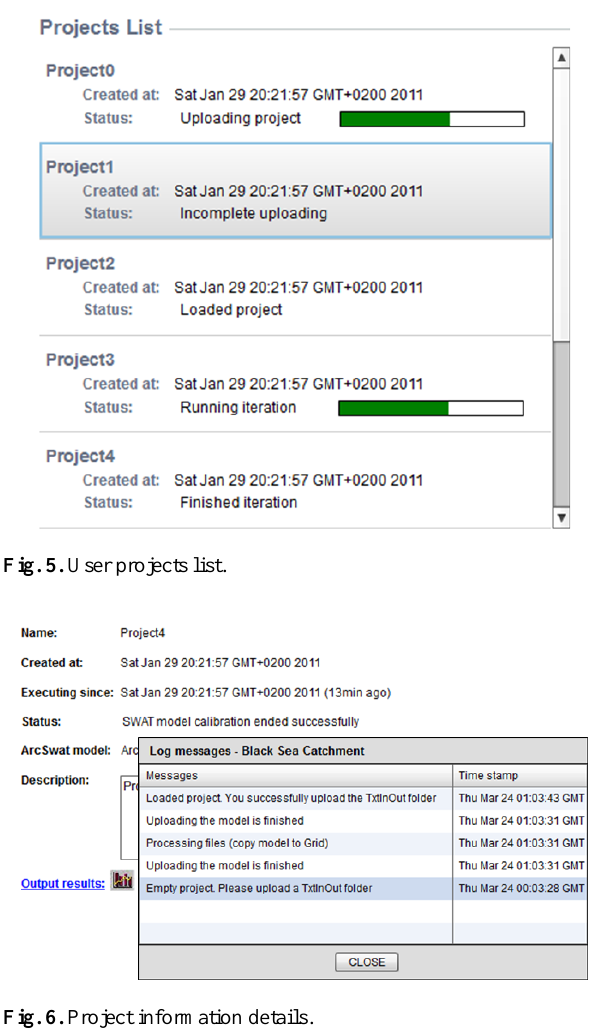
Fig. 6. Project information details.